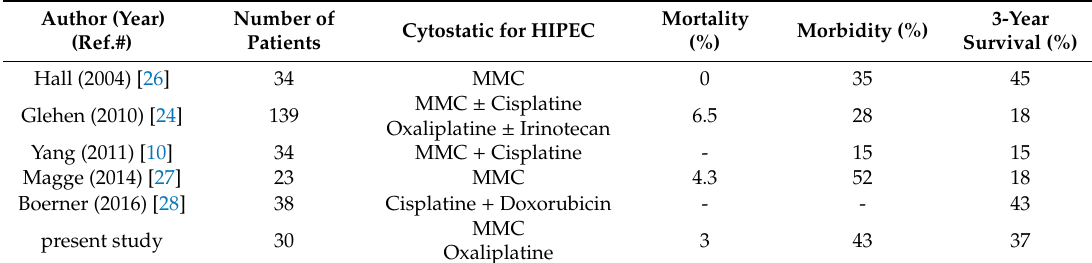
Table 5. Selected case series reporting outcome of the CRS with HIPEC with various preoperative systemic chemotherapy